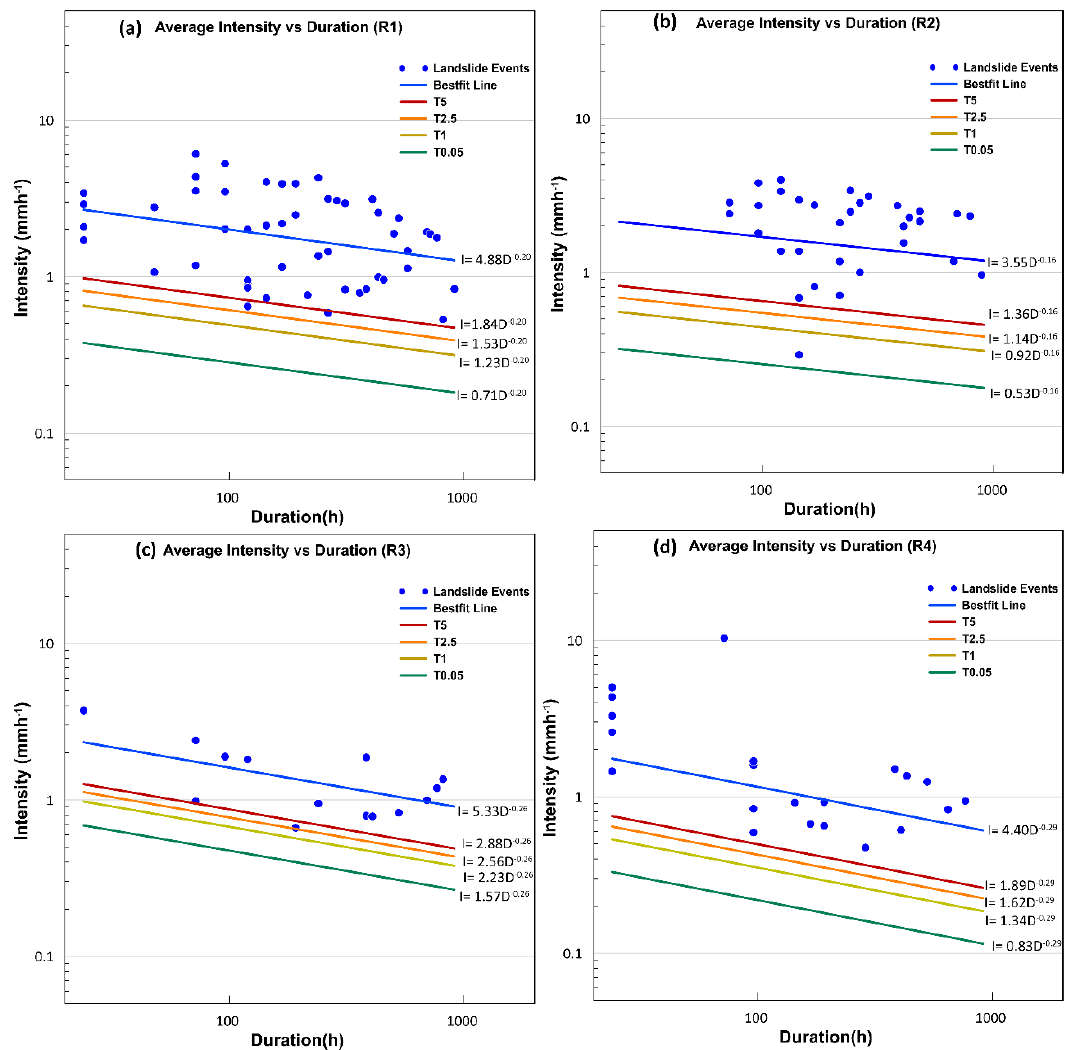
Figure 9. Local scale intensity–duration thresholds established for Wayanad with different exceedance probabilities. ( a ) Average intensity vs duration (R1), ( b ) Average Intensity vs Duration (R2), ( c ) Average Intensity vs Duration (R3), ( d ) Average Intensity vs Duration (R4).